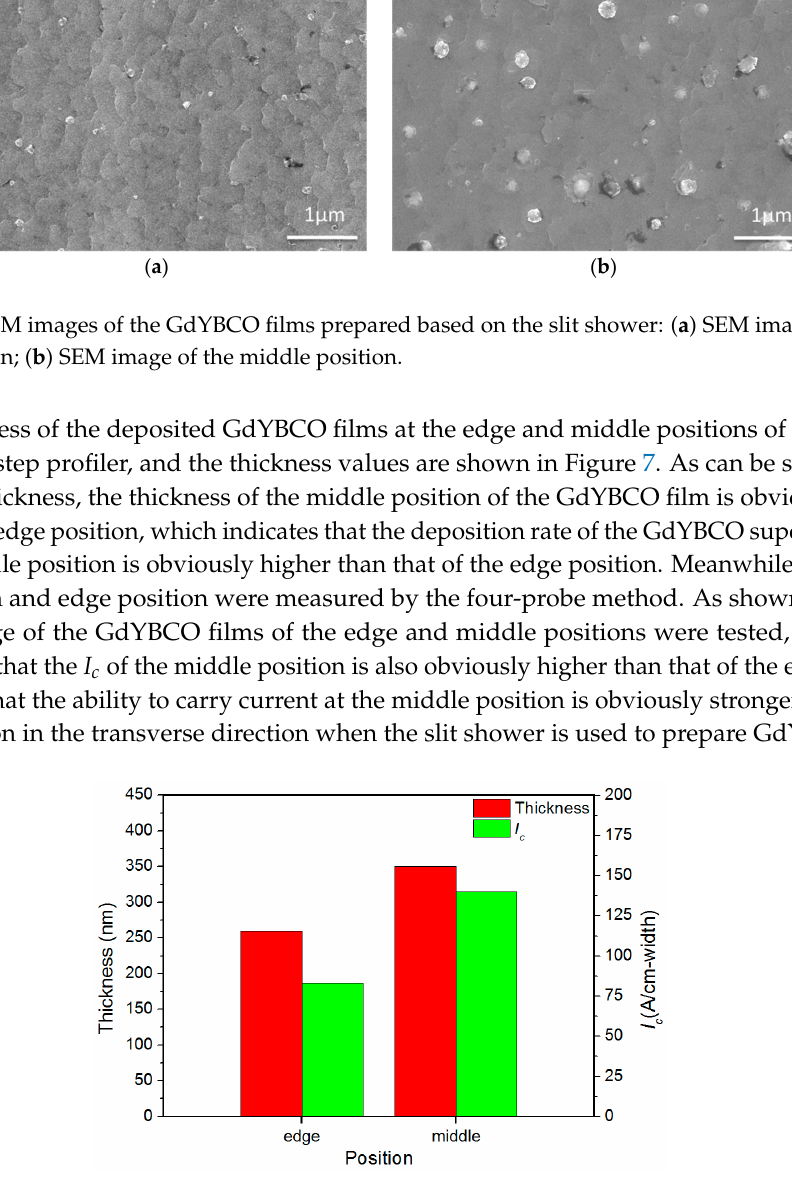
Figure 7. The thickness and I c histograms of the GdYBCO films prepared based on the slit